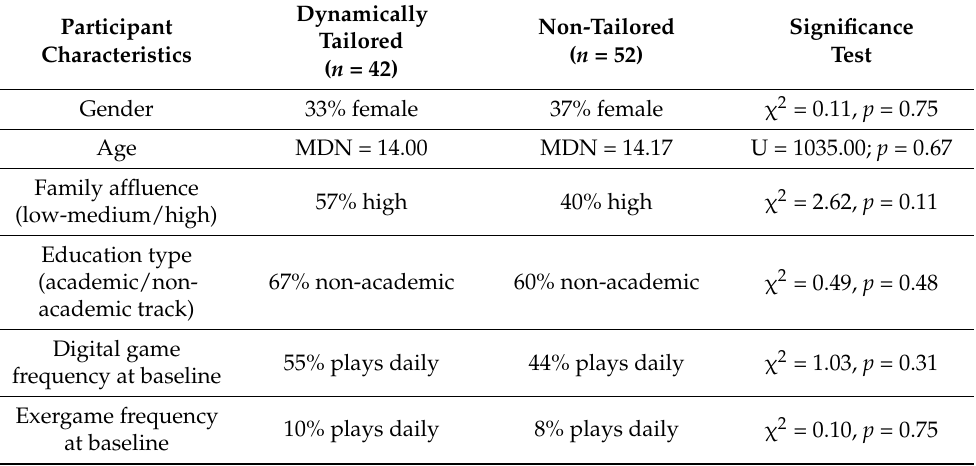
Table 2. Descriptive information on intervention